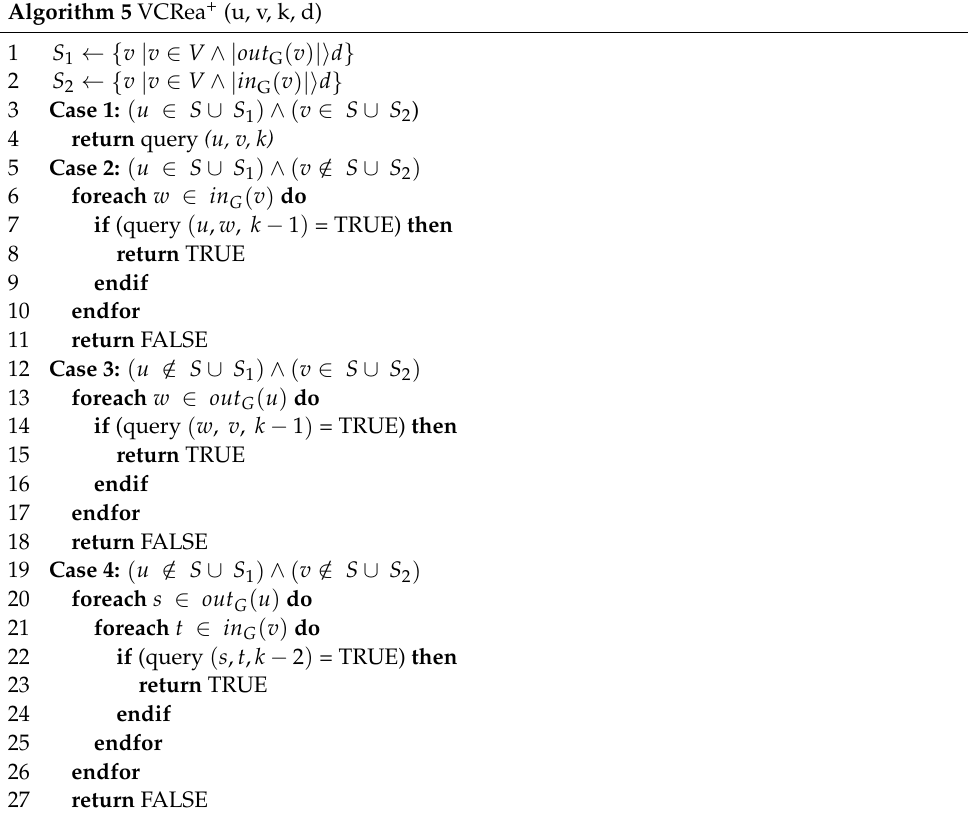
Algorithm 5 VCRea + (u, v, k,